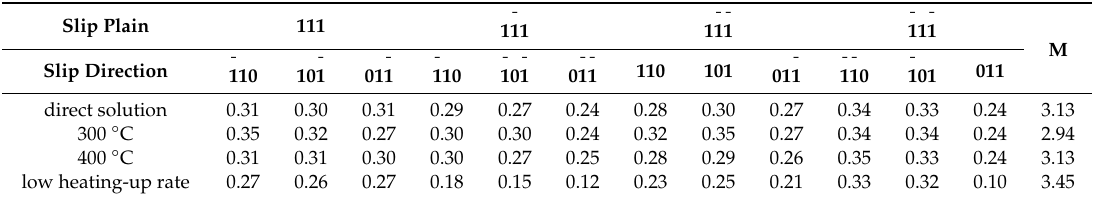
Table 7. Weighted Schmid factors and average Schmid factors corresponding to the {111} < 110 > slip system and of samples with di ff erent annealing treatments prior to